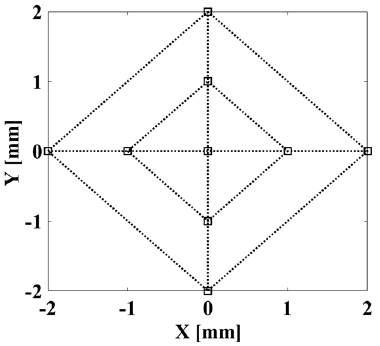
FIG. 6. Test particle positions on the cathode plane used in the simulations for kick